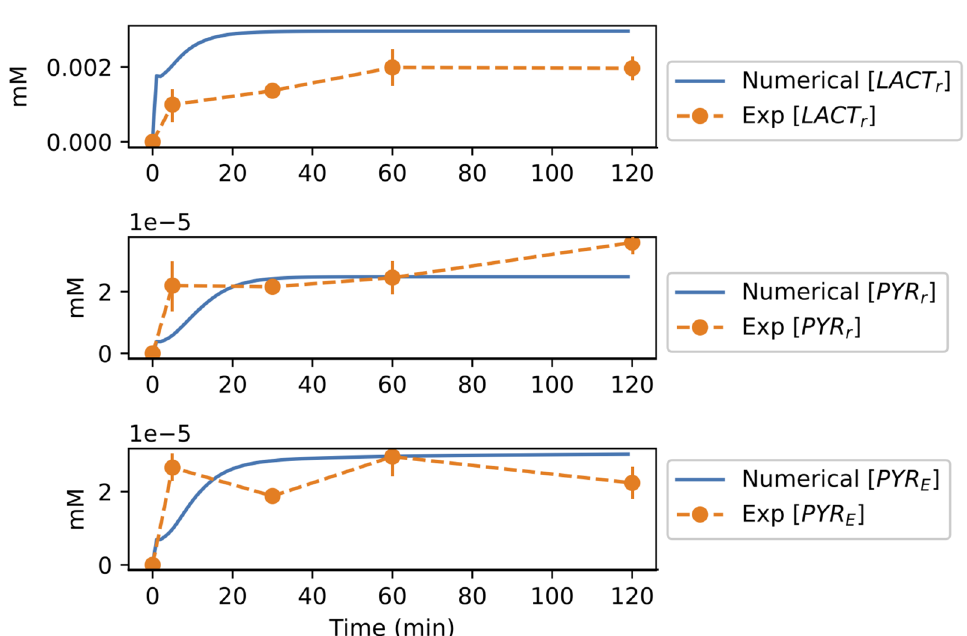
Figure 5. The concentrations obtained from running numerical simulations of system (1)–(11) for 120 min, compared to the mean of the experimental results in Kanow et al. 42 . Using a protein concentration of 20 mg/ml as reported in Du et al. 59 , we converted the mean of the experimental data (n = 3 for each time point) 42 given in pM/ µ g, to mM/ml (orange markers) and compared our numerical results (blue lines) to the experimental data for lactate (top) and pyruvate (center) in the rods, and pyruvate in the RPE (bottom). In this figure the vertical orange lines represent the standard